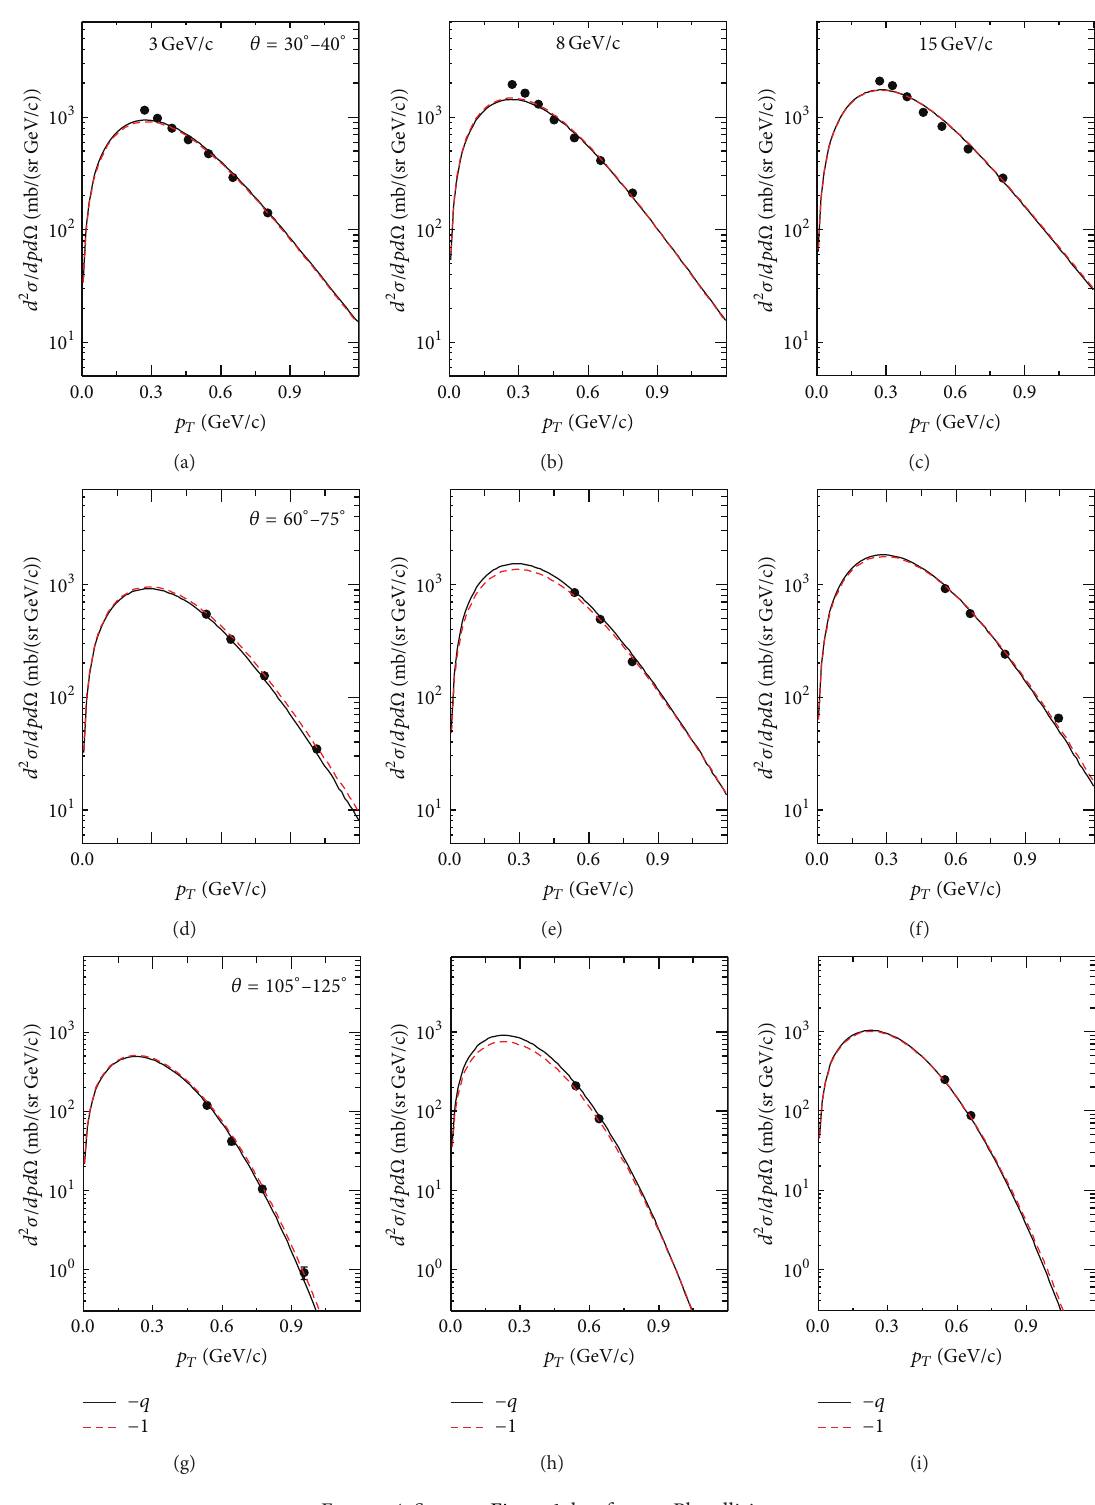
Figure 4: Same as Figure 1, but for 𝑝 + Pb